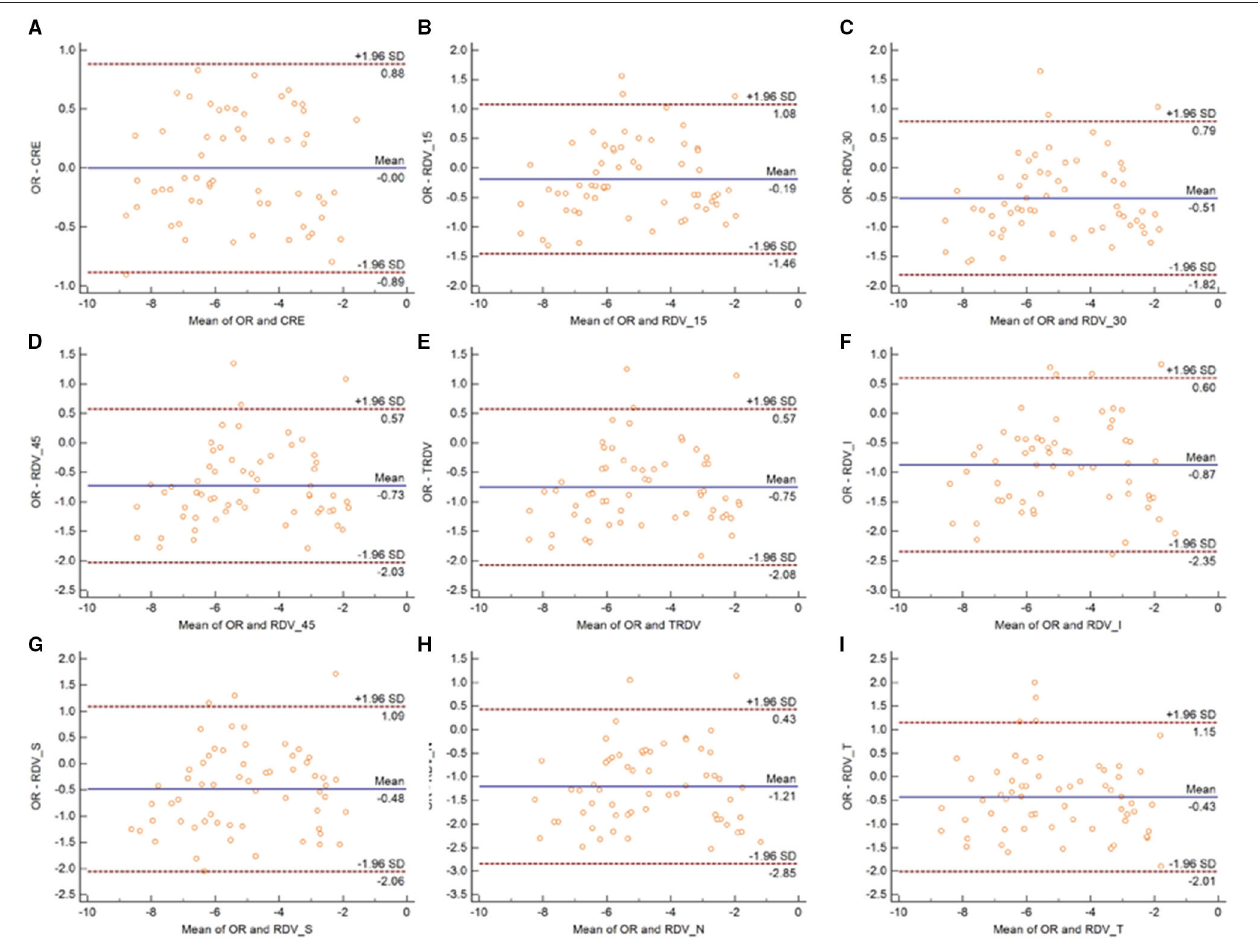
FIGURE 3 | Bland–Altman plots between SR and CRE (A) , RDV-15 (B) , RDV-30 (C) , RDV-45 (D) , TRVD (E) , RDV-I (F) , RDV-S (G) , RDV-N (H) , and RDV-T (I) in non-cycloplegia eyes. The solid line shows the mean difference (bias), and the upper and lower lines represent 95% limits of agreement.